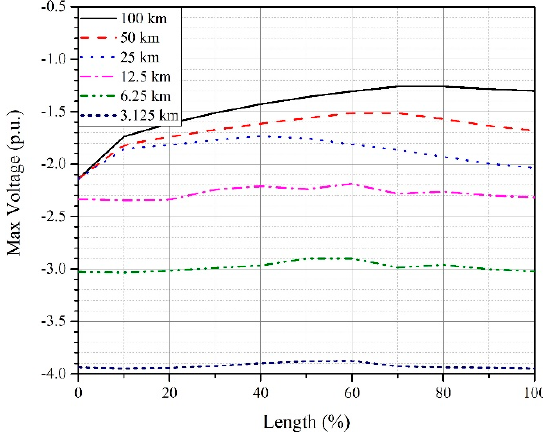
Figure 11. Maximum core-ground voltage along the length in cables with different lengths.